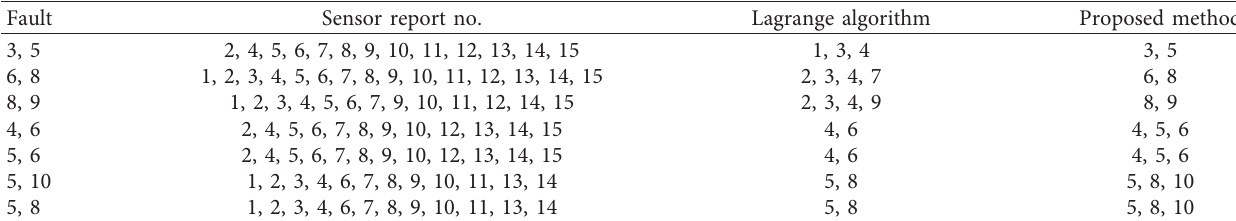
Table 3: The experiment results with the Lagrange relaxation algorithm and the proposed method. Fault Sensor report